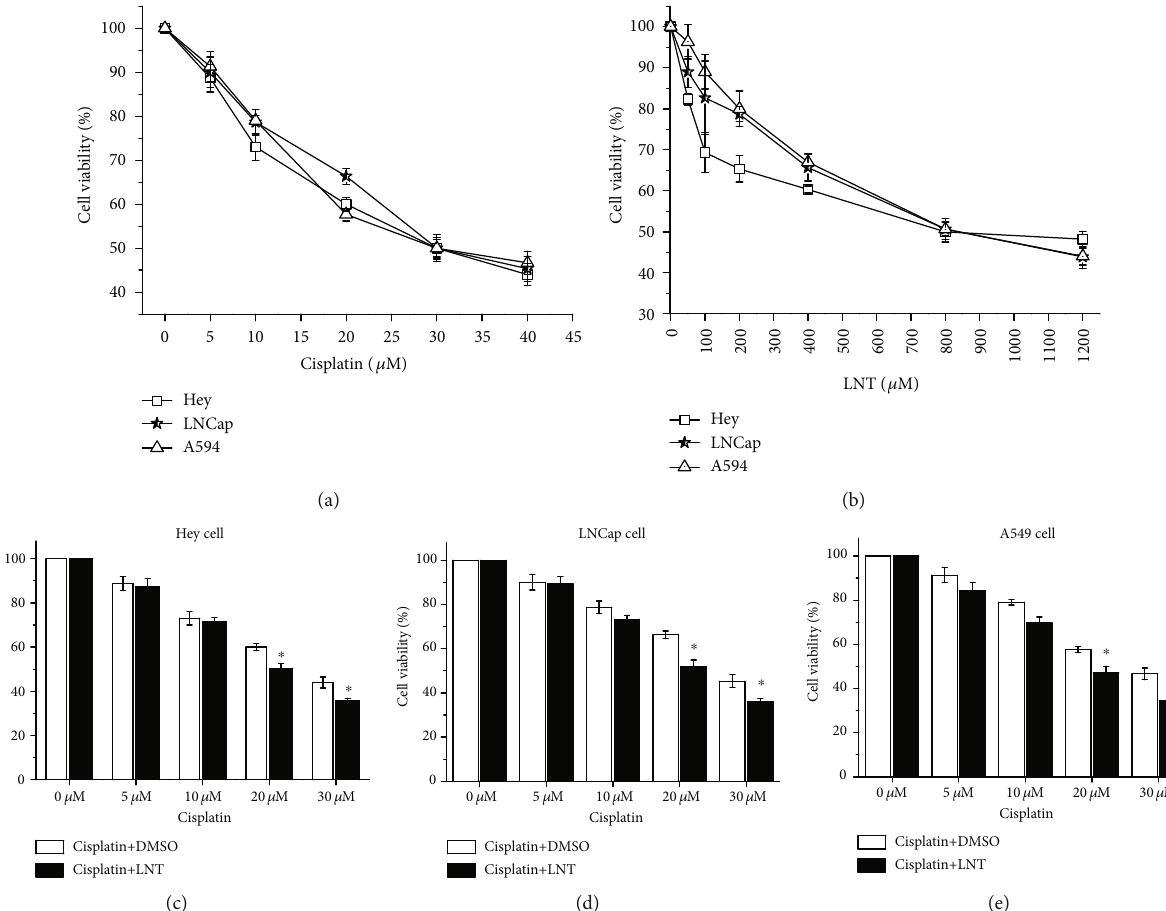
Figure 2: Cytotoxic e ff ect of cisplatin on tumor cells enhanced by lentinan. (a) The cytolytic activity of cisplatin on di ff erent doses to Hey cells, LNCap cells, and A594 cells. (b) The cytolytic activity of LNT on di ff erent doses to Hey cells, LNCap cells, and A594 cells. (c – e) The cytolytic activity of the combination of LNT (800 μ M) and cisplatin to Hey cells (c), LNCap cells (d), and A594 cells (e). ∗ P < 0 : 05 , ∗∗ P < 0 : 01 , signi fi cantly di ff erent from the cisplatin+DMSO